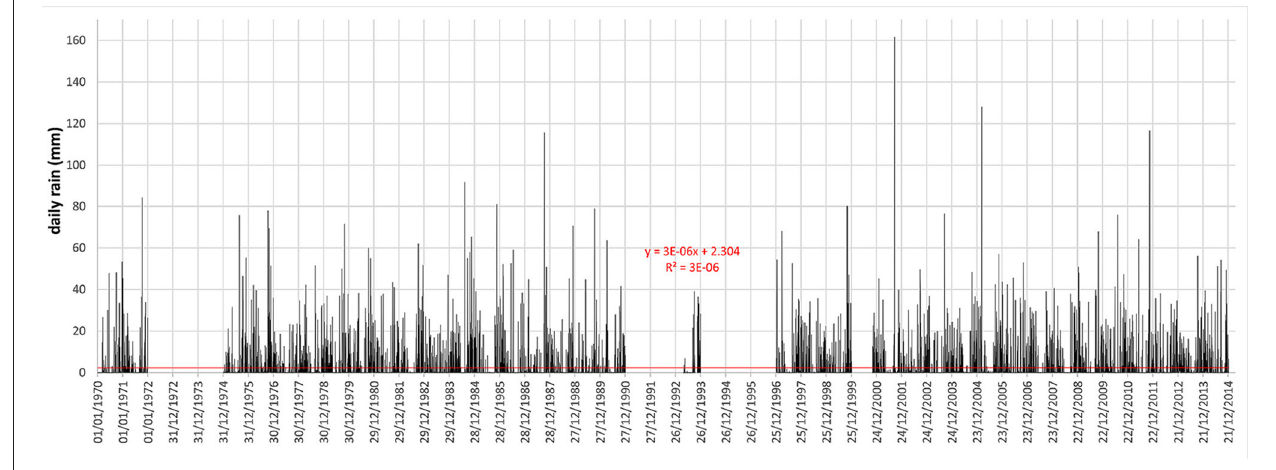
FIGURE 4 | Daily rain time series measured by the Pozzuoli rain gauge.